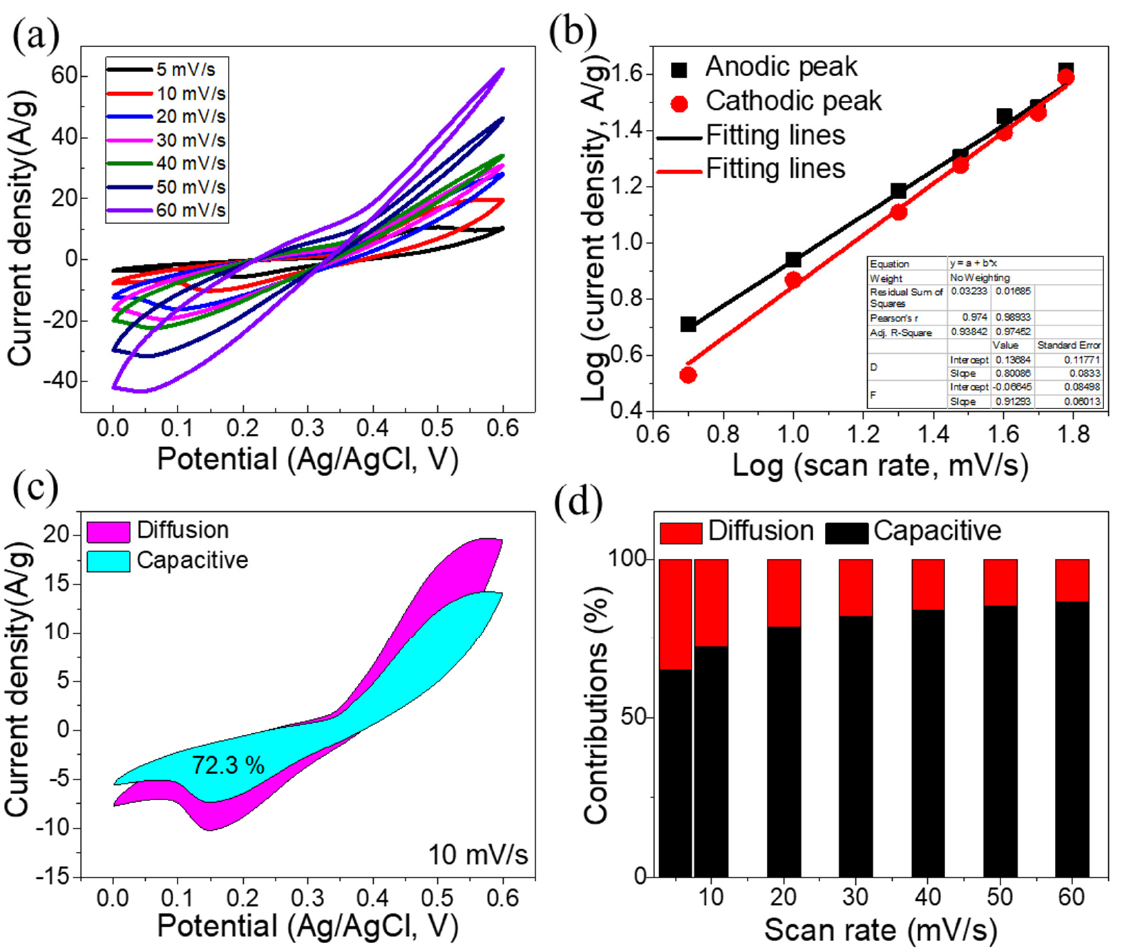
Figure 5. ( a ) CVs of Ni-NPs; ( b ) b -value’s calculations; ( c ) capacitive/diffusion-controlled charge store at 10 mV/s, ( d ) capacitive/diffusion-controlled charge store at various scan rates (5–60 mV/s). To gain a better understanding of the kinetic feature of the ion diffusion that is re- sponsible for the charge storage property of the electrode, an electrochemical impedance spectrum (EIS) investigation was carried out. Figure 6 provides a visual representation of the Nyquist plot for the Ni-NP electrode. Any absence of a semicircular zone in the plot is indicative of low faradaic resistances in the electrolyte. The Nyquist plot shown in Figure 6 initially intersects the real axis at 45 ◦ . This may be due to the Warburg impedance, which occurs in a porous electrode when an electrolyte ion accesses it. A straightforward EDLC system can be identified by a vertical curve in the lower frequency zone. The Nyquist plot was well-represented by an equivalent circuit, which can be seen in the inset of Figure 6.